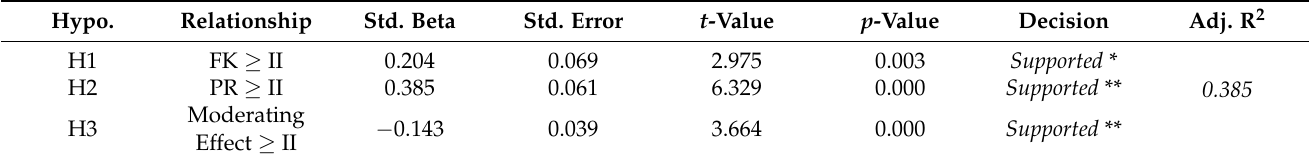
Table 5. Structural model’s path coefficient and regression